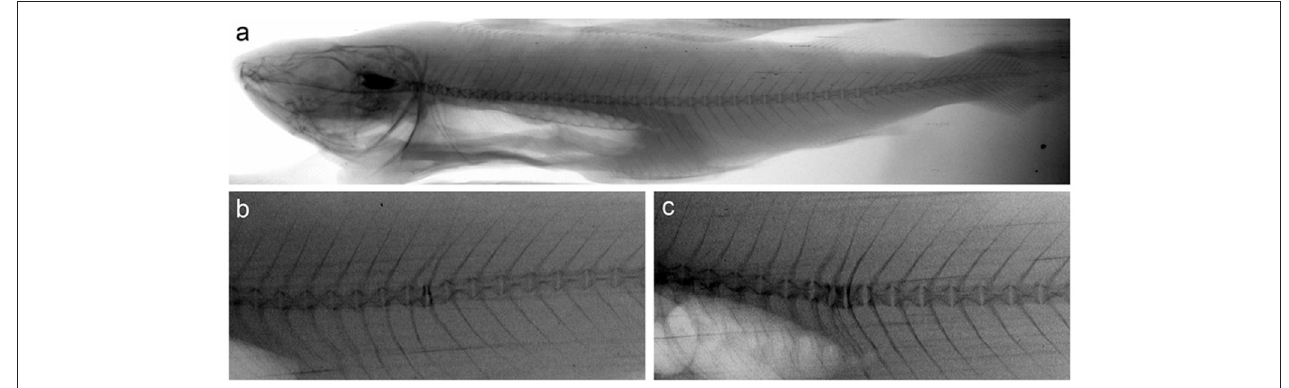
FIGURE 7 | X-ray images of vertebrae of (a) control fish without deformities and (b,c) two fish from the high exposure group with typical deformities. Image (b) shows an individual where two adjacent compressed vertebrae involve a mild lordotic curvature. Image (c) shows an individual where three adjacent compressed vertebrae involve a lordotic